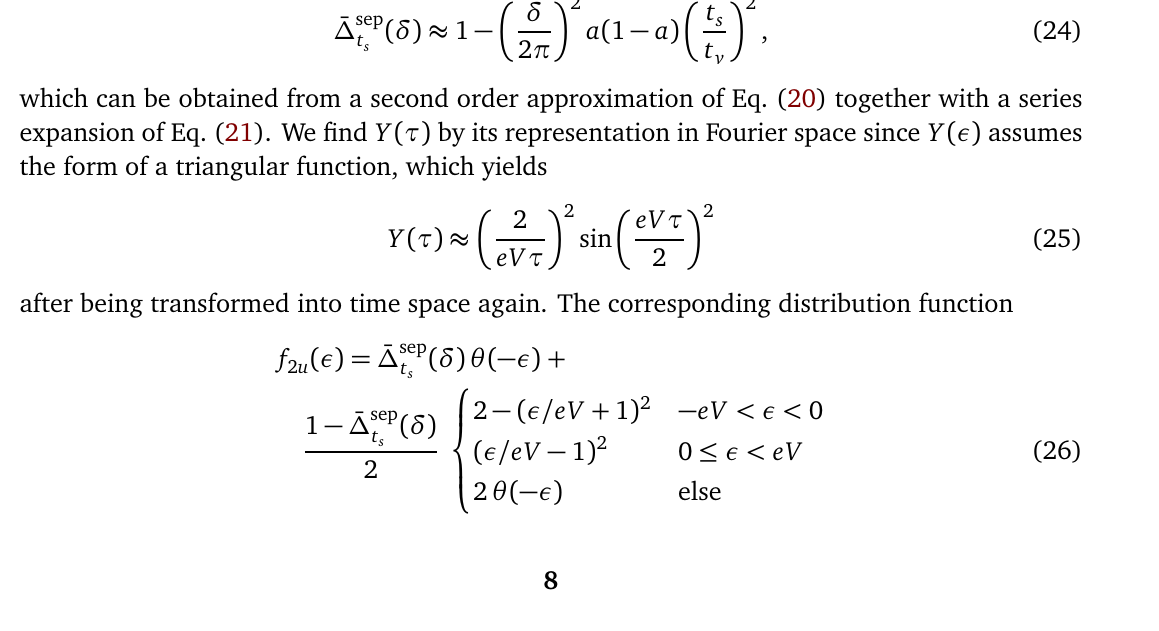
/ t = 100 is e v ( δ ) t s